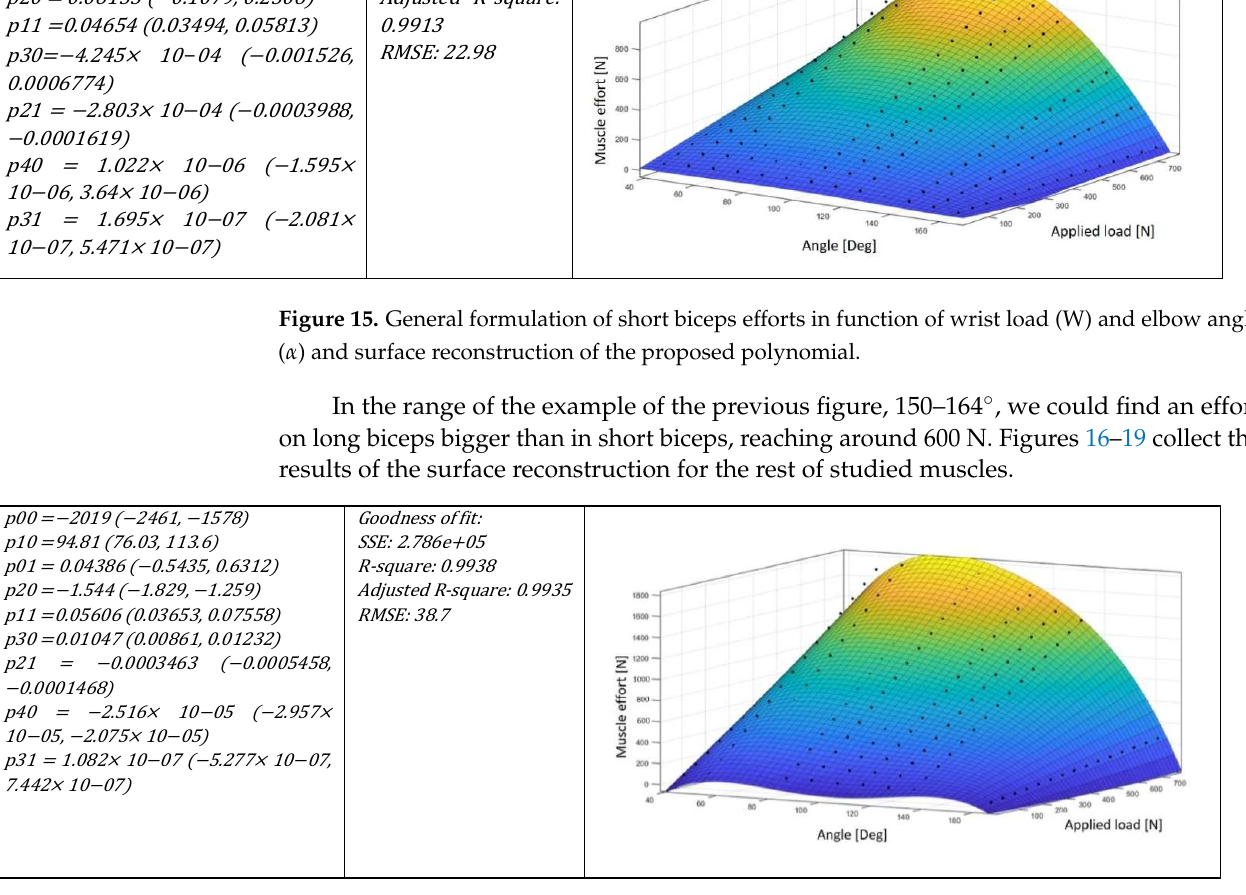
Figure 16. General formulation of long biceps efforts based on wrist load (W) and elbow angle ( α ) and surface reconstruction of the proposed polynomial.